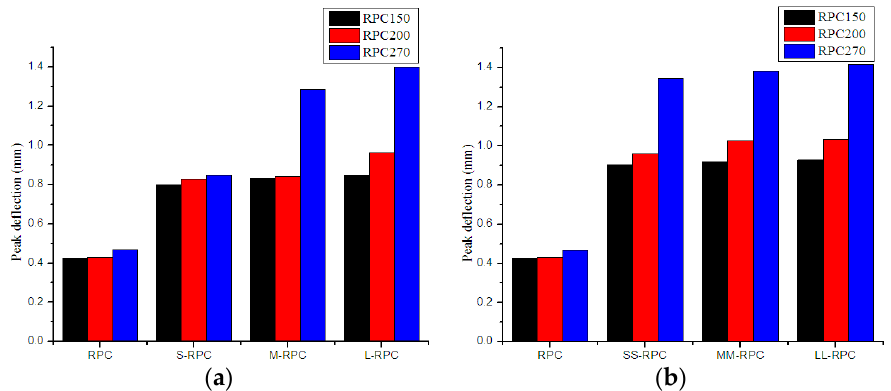
Figure 8. Effects of steel fiber length on peak deflection of RPC: ( a ) 0.5% fiber content and ( b ) 2.0% fiber content.